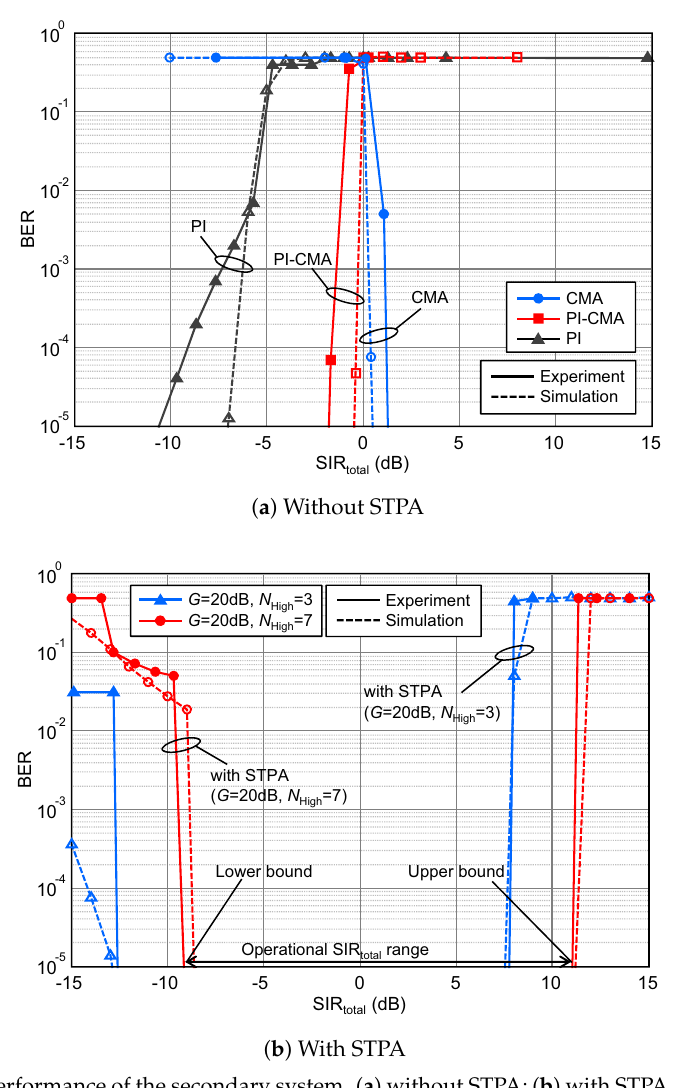
Figure 8. BER performance of the secondary system. ( a ) without STPA; ( b ) with STPA. STPA: subcarrier transmission power